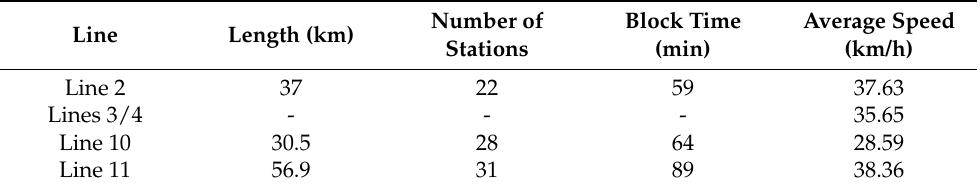
Table 2. Speed of subway lines in Changning